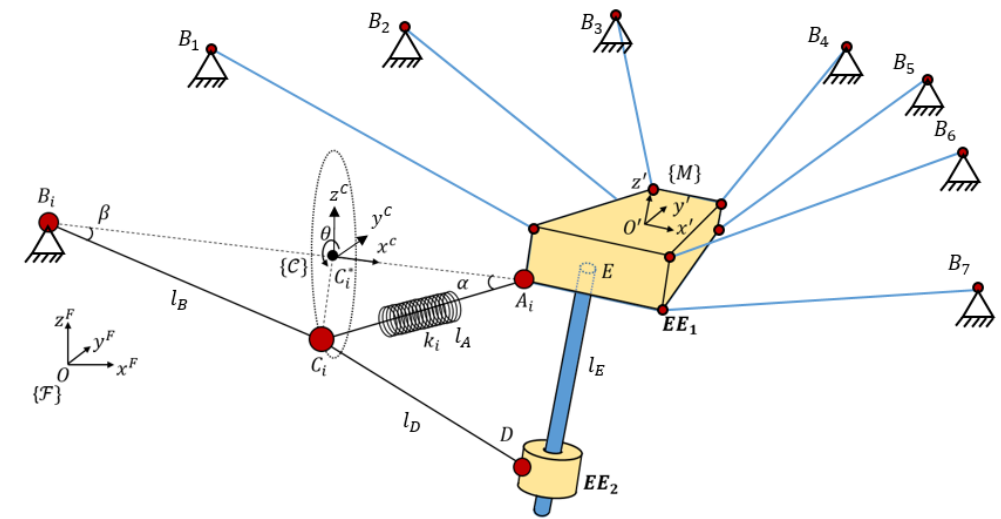
Figure 3 . Schematic description of a cable-driven robot with a reconfigurable platform of two bodies ( EE 1 and EE 2 ). The compliant actuator that parted from B i to A i and D could control both bodies of the reconfigurable end effector at the same time.